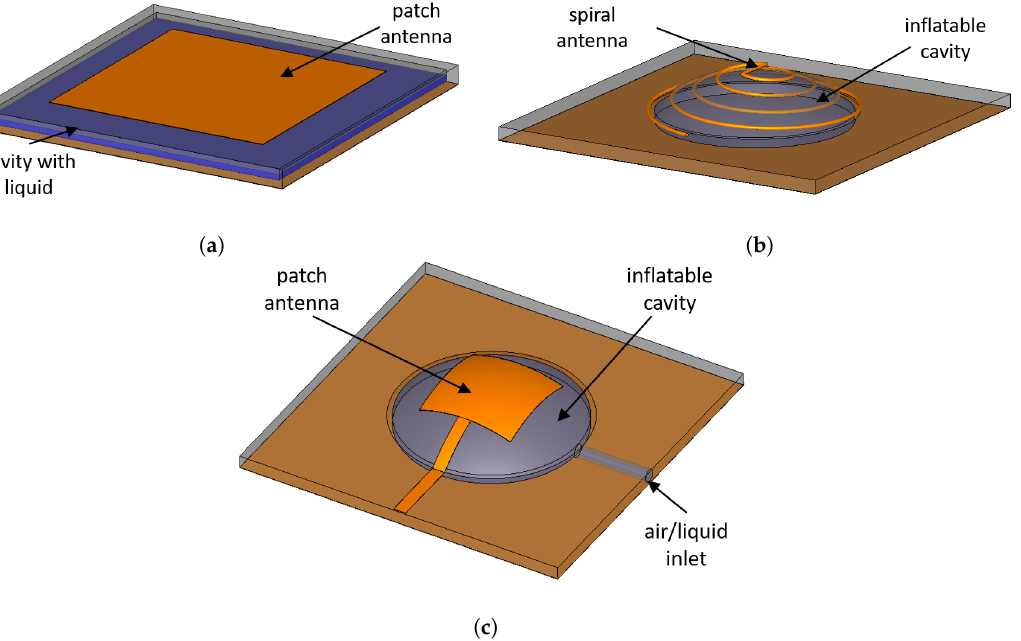
Figure 6. Planar antennas with a cavity. ( a ) [91], ( b ) [92], ( c )